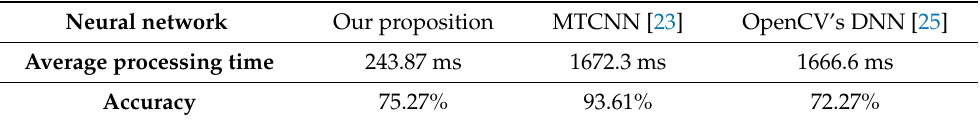
Table 6. The results of an experimental comparison of accuracy and time needed to process a single image frame for several different